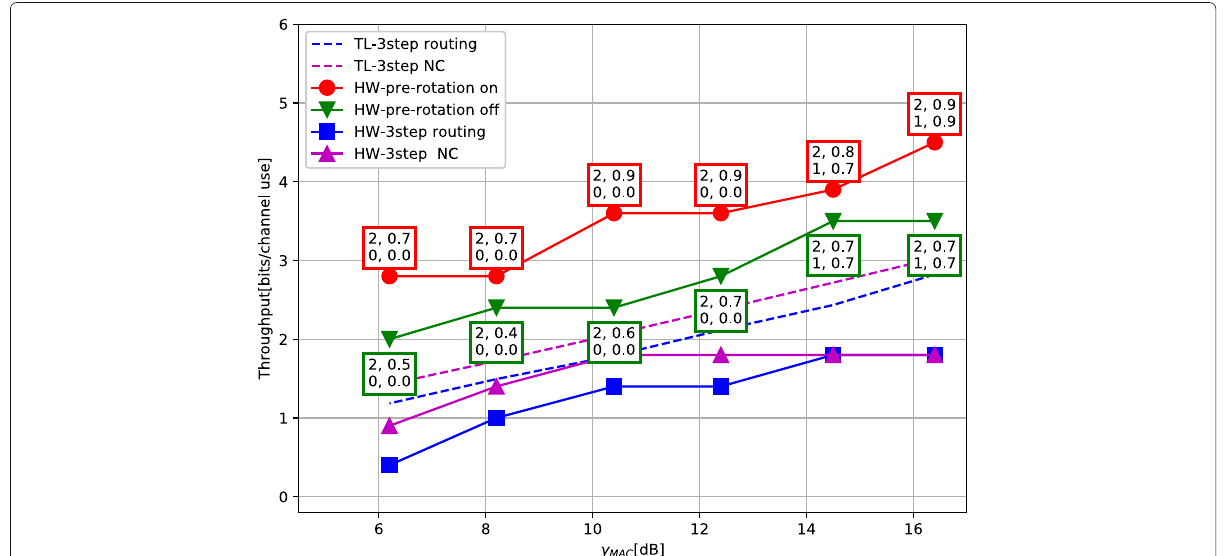
Fig. 20 Performance comparison for the setup γ BC ≈ γ MAC and γ HSI ≈ γ MAC +3dB. The numbers in boxes correspond with particular values (first row: ( N b , r b ) , second row: ( N s , r s ) ) achieving a given maximal throughput